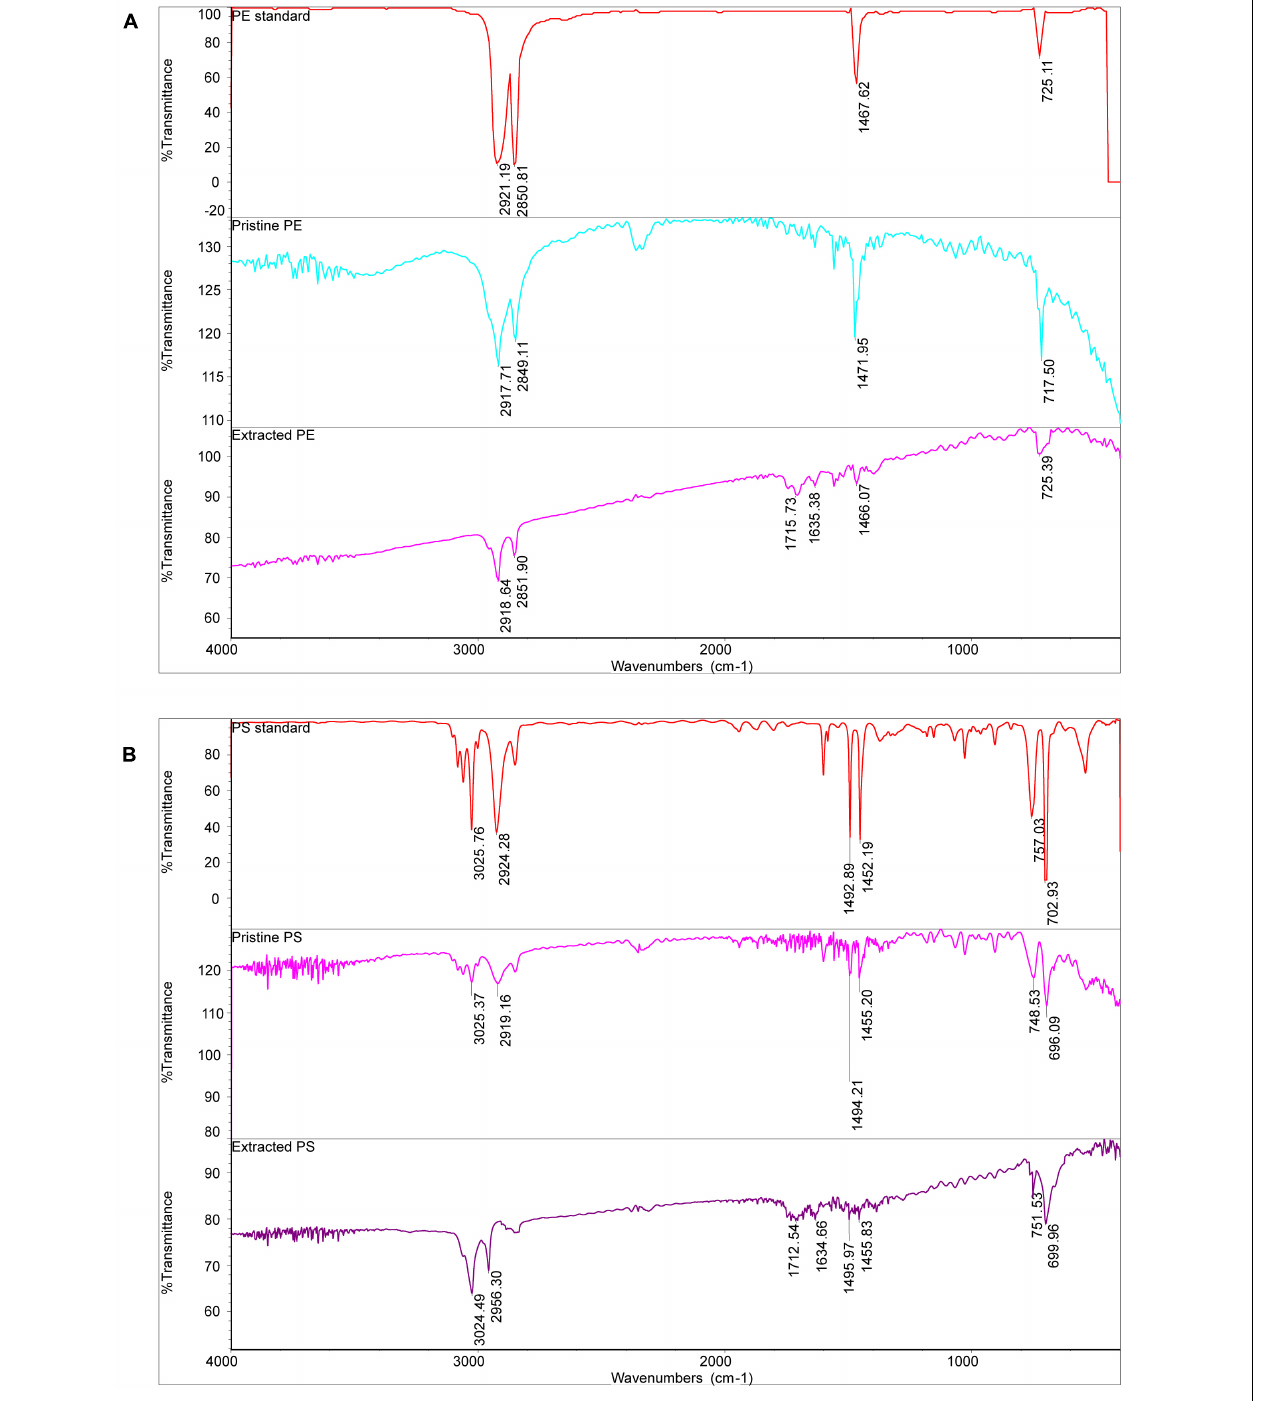
Seohaeicola , Stappia , and Polycyclovorans ( Figure 8A ). The heat-map chart based on the genus level showed that the three treatments all had higher species richness ( Figure 8B